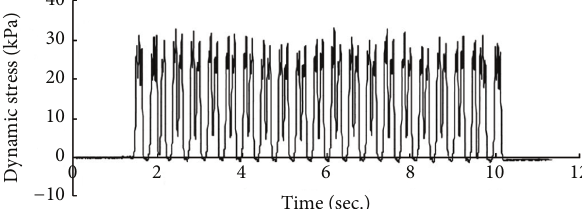
Figure 3: Field measurements of stress pulse wave on subgrade [25]. Figure 2. Consistent test results have been obtained using the same processing method in Lin et al. [33].